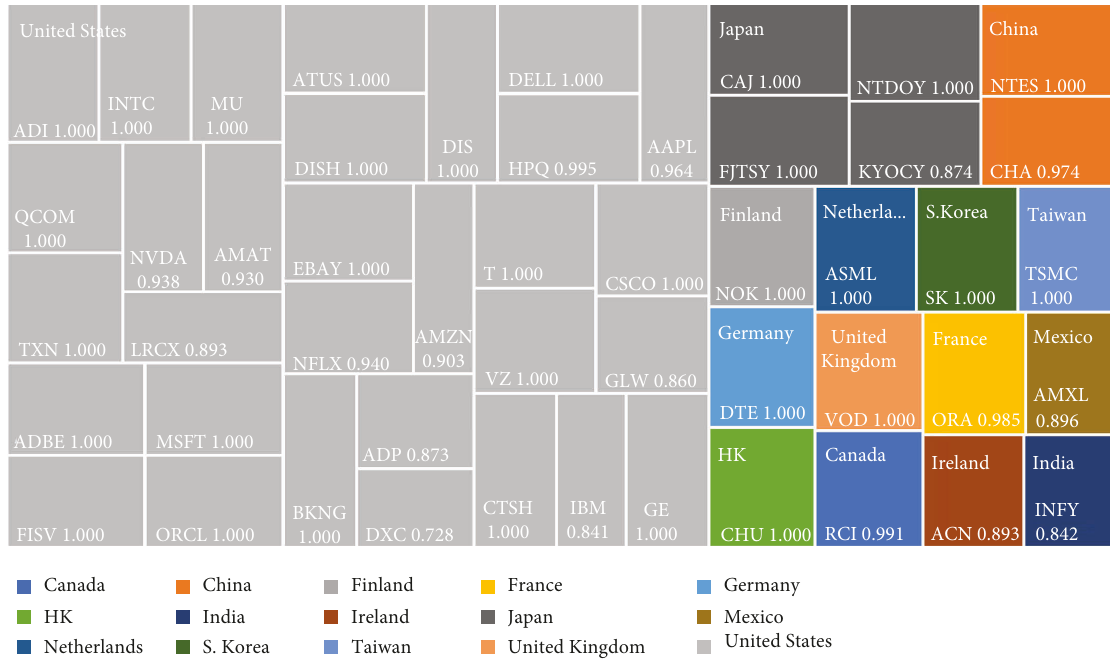
Figure 3: Tree map of profitability